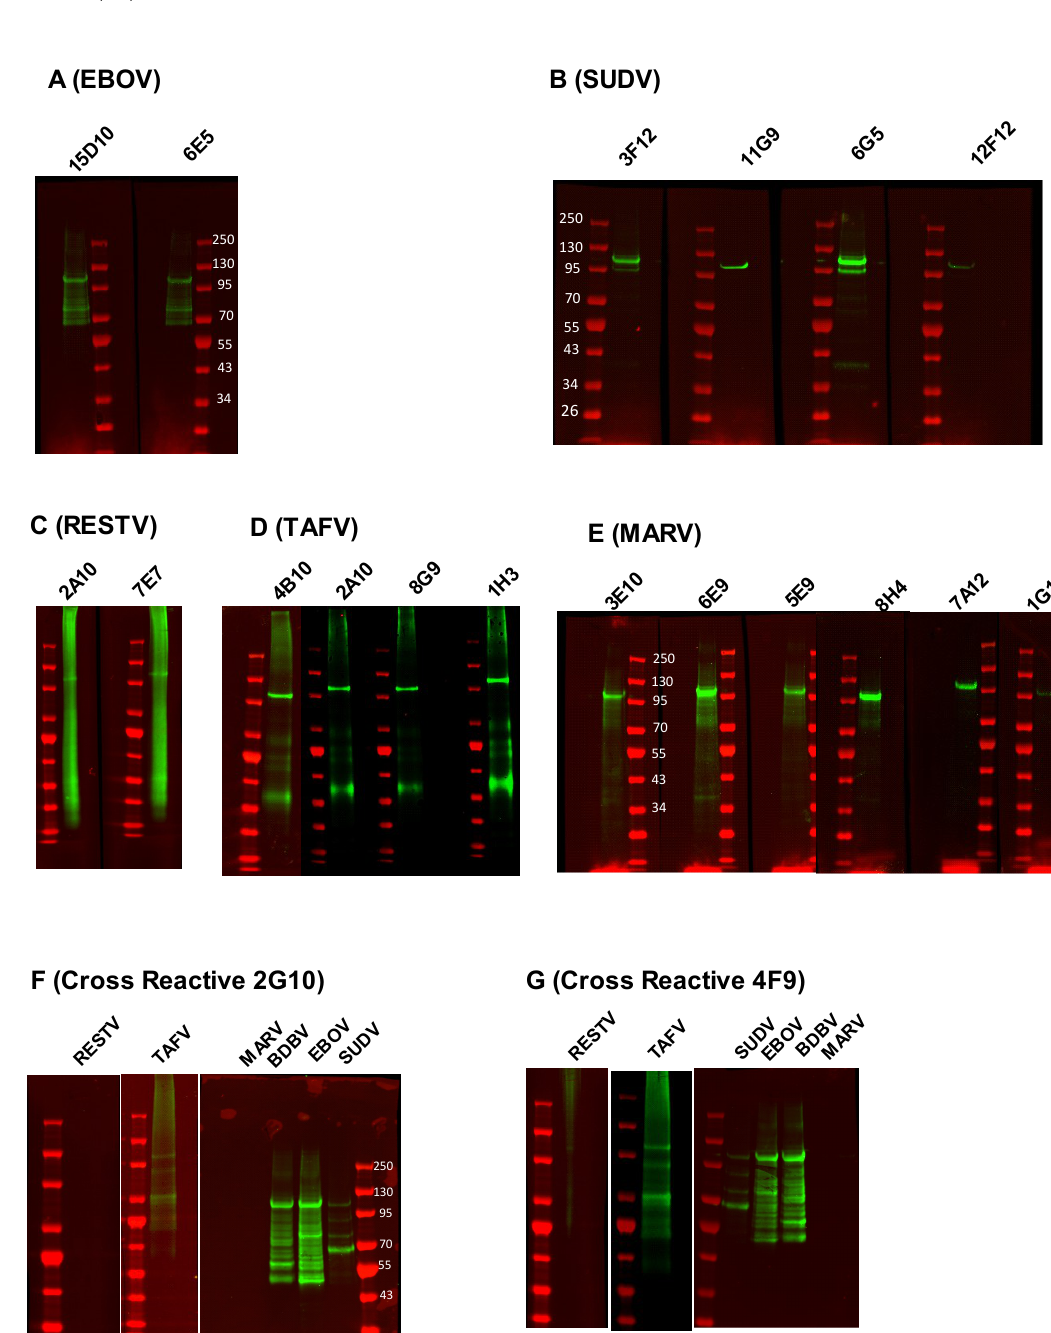
Figure 2. Western blot analysis of anti-filovirus mAbs against wild-type filovirus NP. 10 µ g of purified irradiated EBOV ( A ), SUDV ( B ), RESTV ( C ), TAFV ( D ), and MARV ( E ) were resolved in SDS-PAGE gels, and the proteins were transferred into nitrocellulose membranes. The membranes were treated with (A) 15D10 and 6E5; (B) 3F12, 11G9, 6G5, and 12F12; (C) 2A10 and 7E7; (D) 4B10, 2A10, 8G9, and 1H3; (E) 3E10, 6E9, 5E9, 8H4, 7A12, and 1G10; mAbs. Fluorescent-labeled goat anti-mouse monoclonal secondary antibodies detected the NP. 10 µ g of purified RESTV, TAFV, SUDV, EBOV, BDBV, and MARV were resolved into two separate SDS-PAGE gels, the resolved proteins were transferred into nitrocellulose membrane, and the blots were treated with 2G10 ( F ) and 4F9 ( G ) mAbs to detect different filovirus NPs.